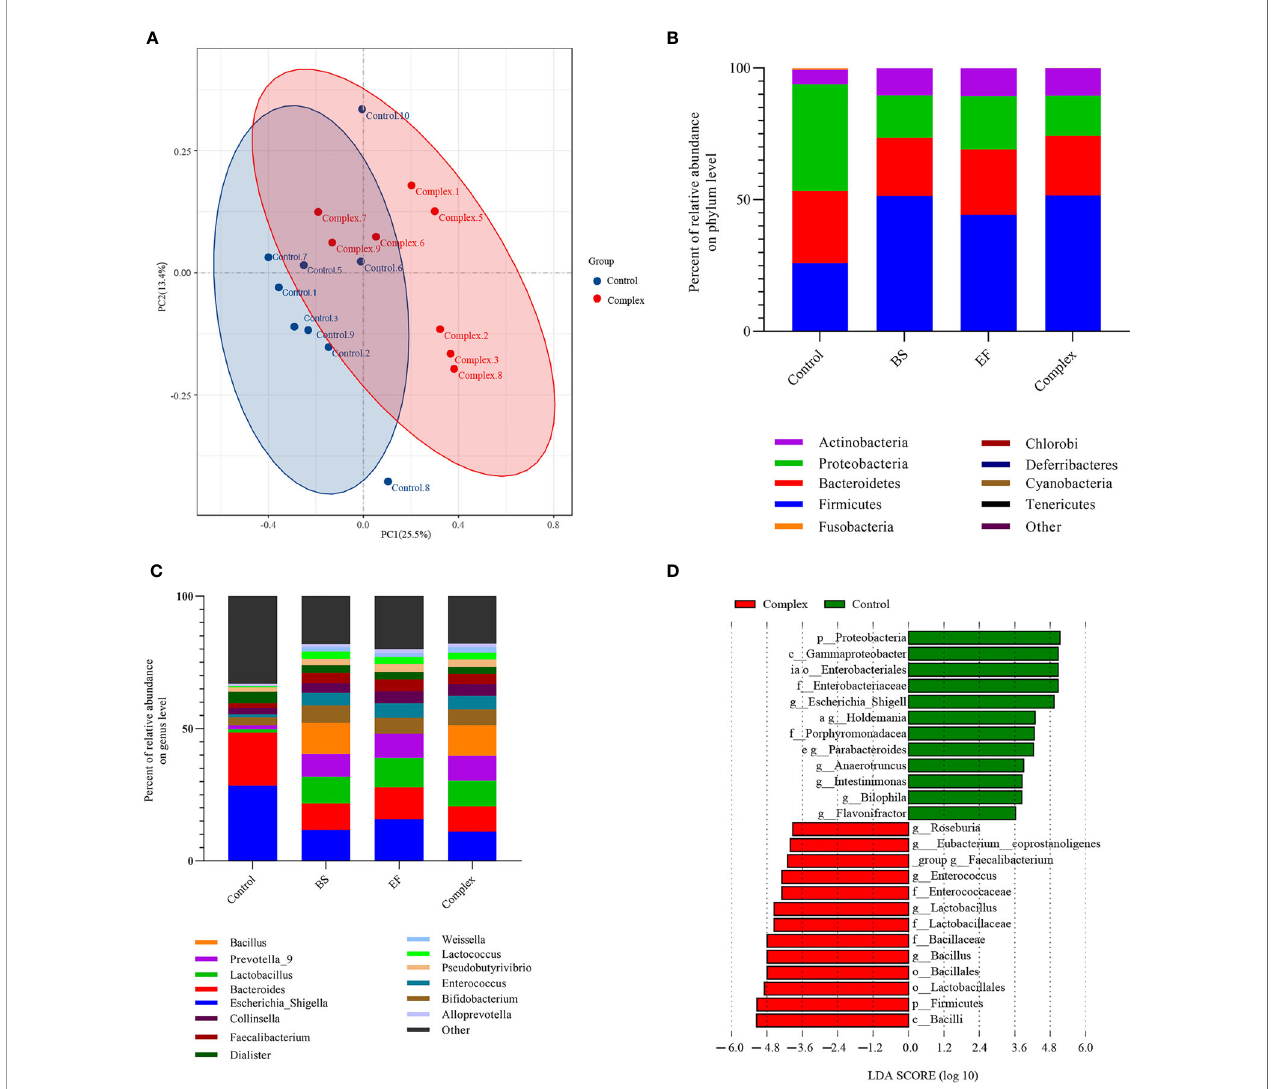
FIGURE 5 | Probiotic treatment differentially changes the human fecal microbiota in vitro fermentation after 24 h of anaerobic incubation. (A) Principal coordinate analysis (PCoA) of unweighted-UniFrac distances of all human fecal microbiome samples; (B, C) Major phyla and genus changes upon Bacillus subtilis , Enterococcus faecium and probiotic complex treatment over time up to 24 h; (D) Microbial cladogram indicating microbial clustering of human fecal microbiota in probiotic complex compared to control treatment. BS represents the Bacillus subtilis group, EF represents the Enterococcus faecium